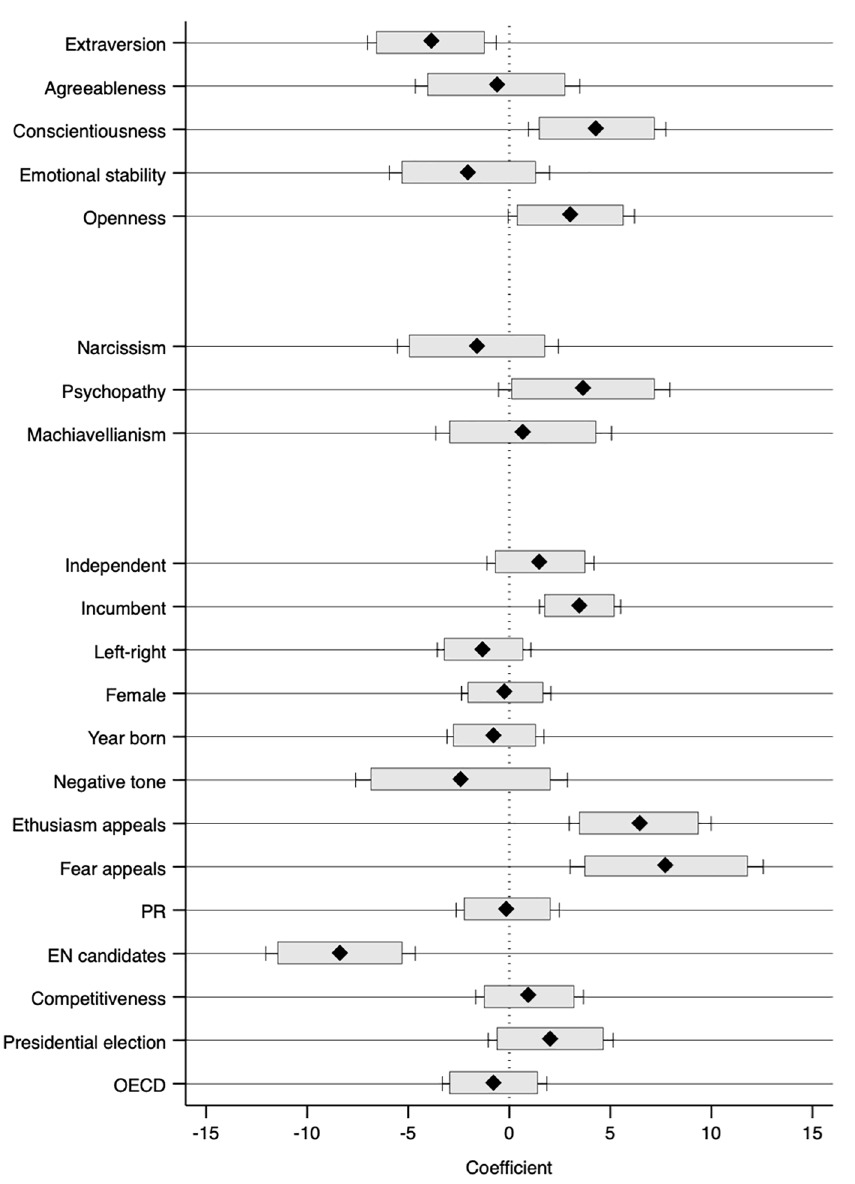
Figure 2. Standardized effects on absolute electoral